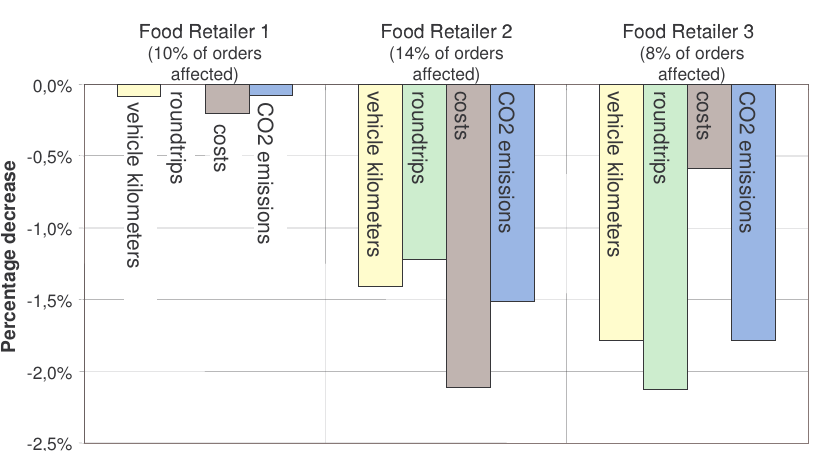
Figure 5. No restrictions (scenario 0b in comparison with scenario 0a) FR1 differs from the other two retailers because of the use of the swap body system. Differences between FR2 and FR3 result from the differences in the assortment and the store density. FR2 combines especially fresh goods orders (these are usually less-than-truckload quantities) for different stores in one roundtrip; both FR2 and FR3 deliver dry groceries in full-truck loads per